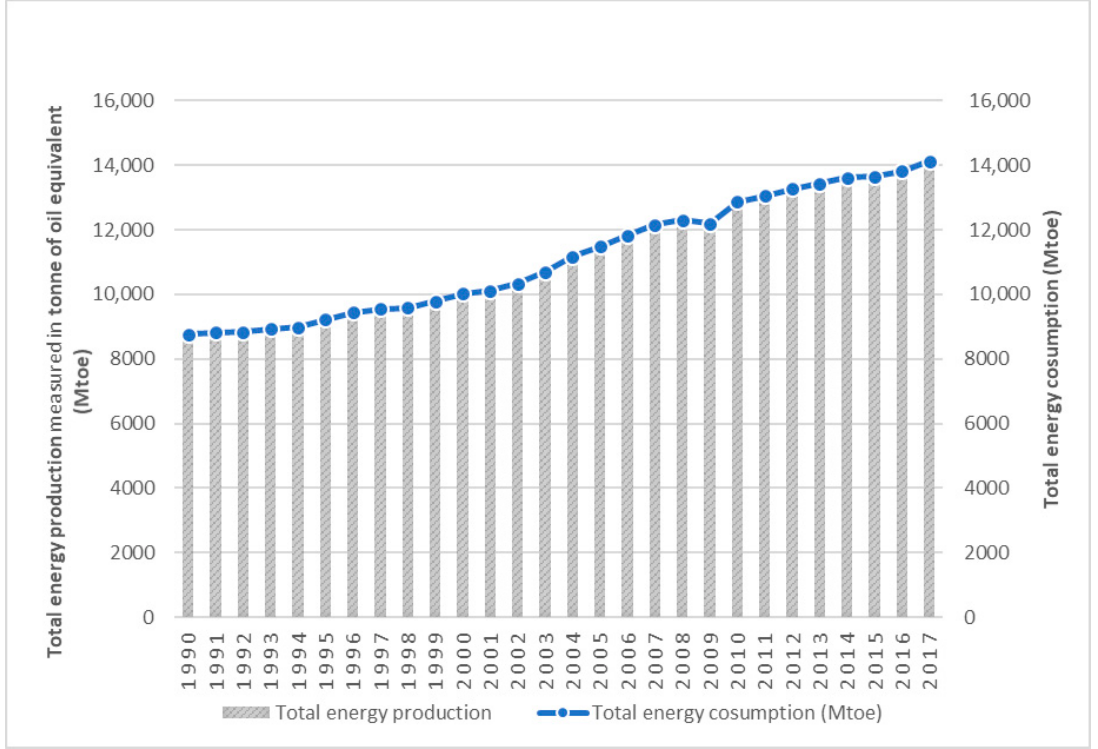
Figure 2. Total energy consumption and production, source: own elaboration based on data [18].